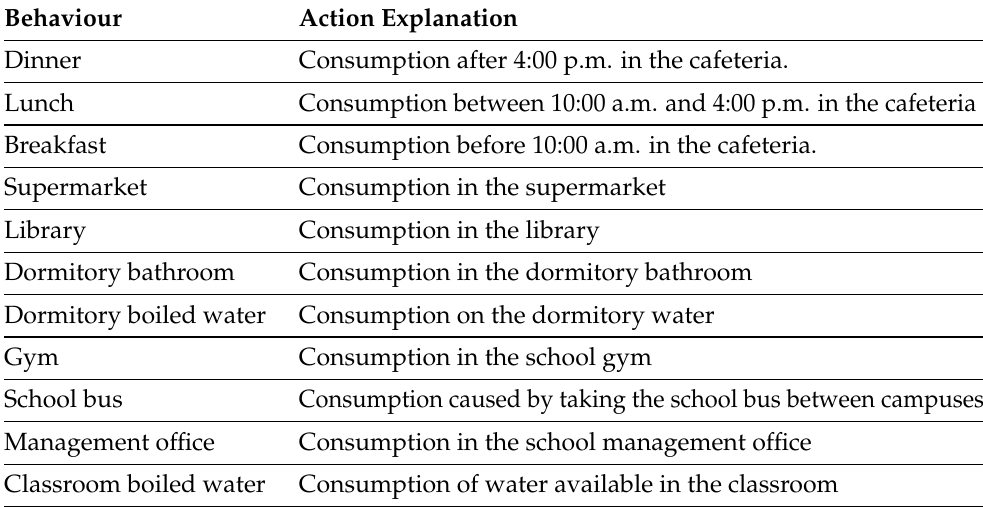
Table 2. Specific explanation of different consumption